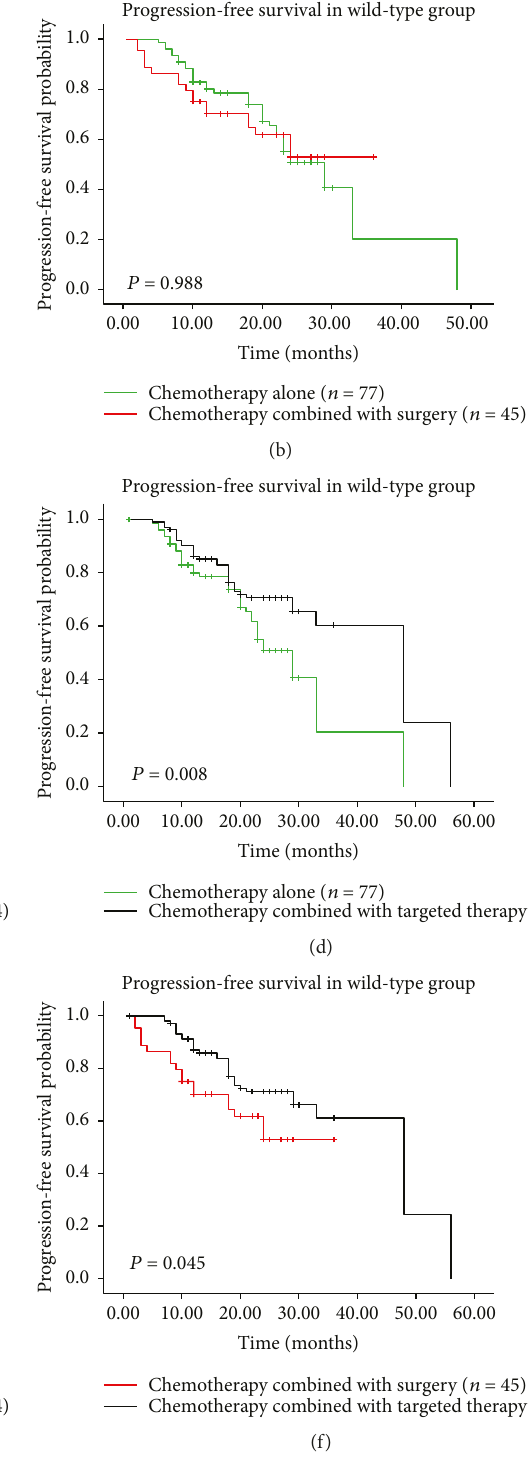
Figure 6: Kaplan-Meier survival curves of wild-type group strati fi ed according to treatment regimens. (a) OS and (b) PFS chemotherapy alone versus chemotherapy combined with surgery, (c) OS and (d) PFS chemotherapy alone versus chemotherapy combined with targeted therapy, and (e) OS and (f) PFS chemotherapy combined with surgery versus chemotherapy combined with targeted therapy. OS: overall survival; PFS: progression-free